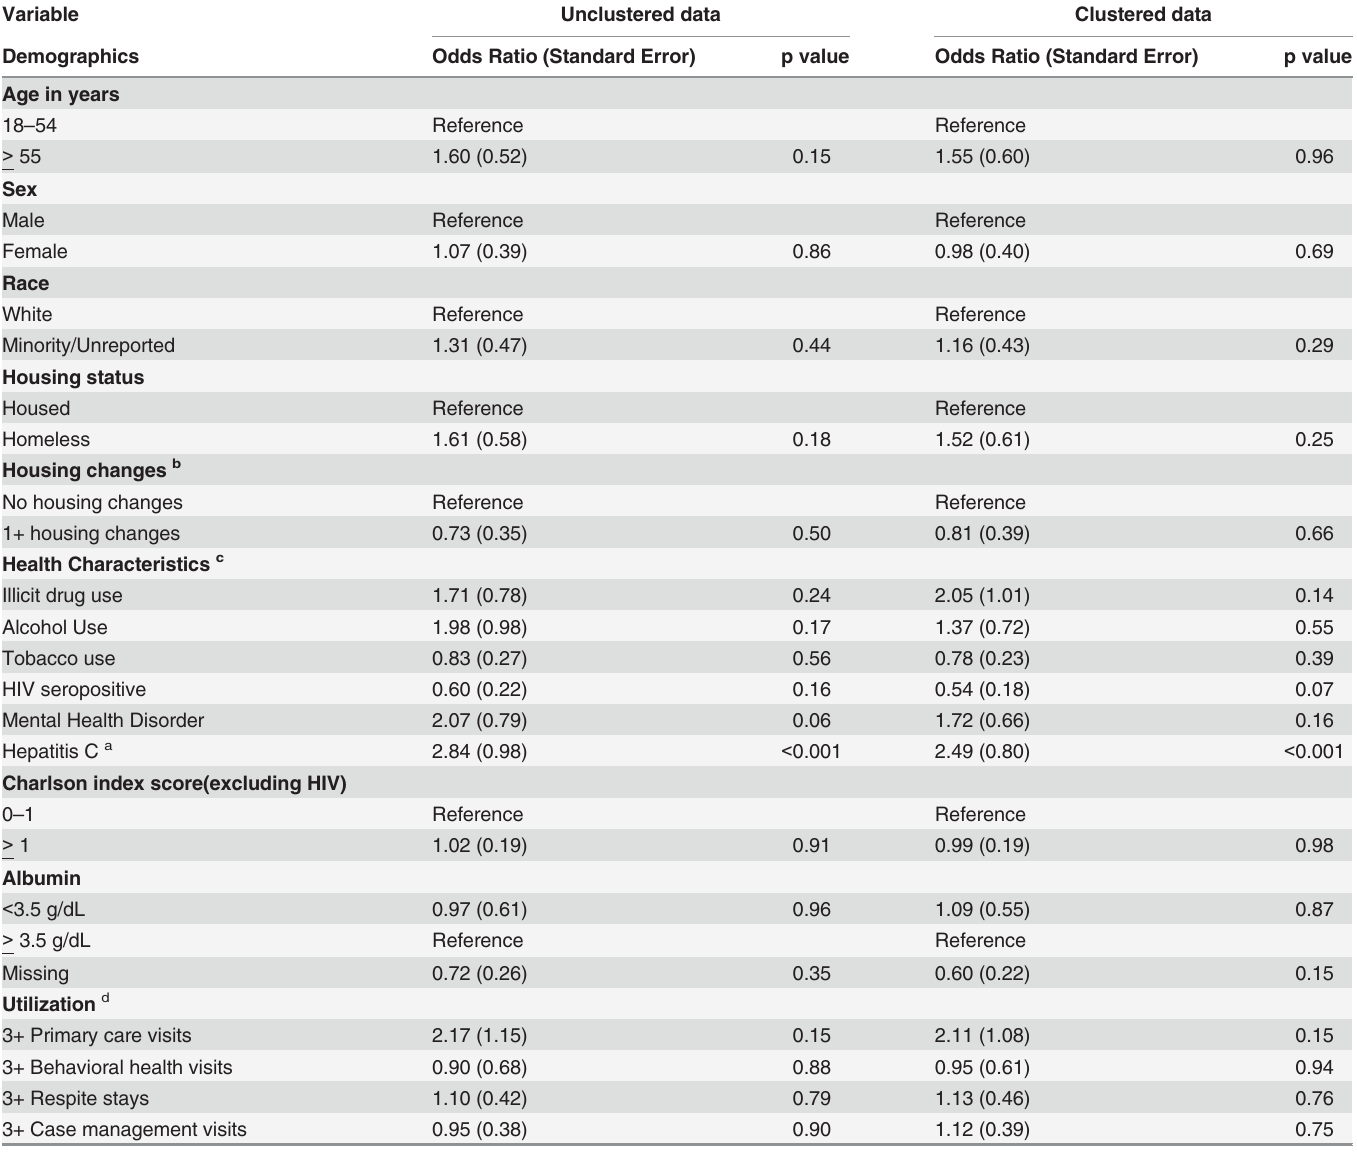
Table 3. Pooled Multivariable Analyses: Predictors of Frequent ER Visits Using Unclustered and Clustered